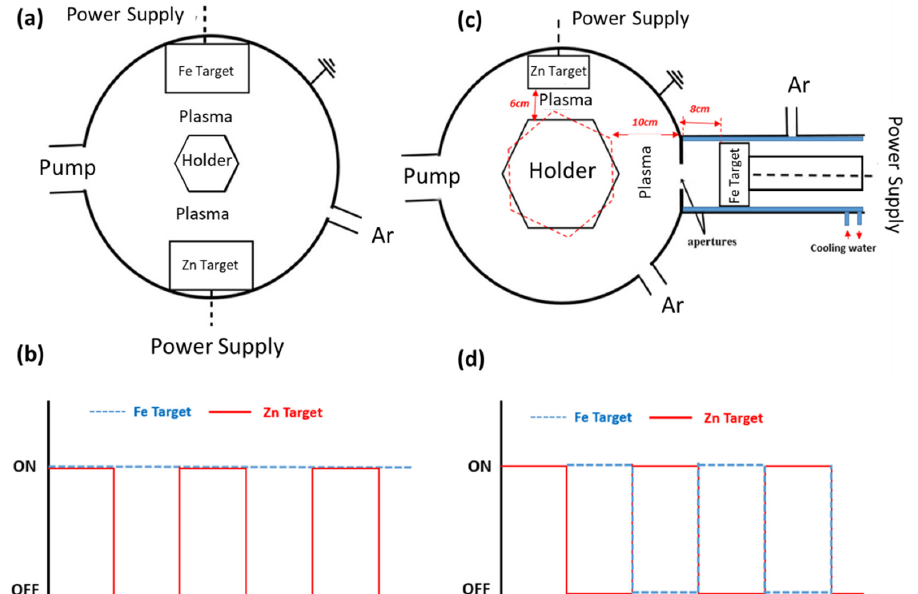
Figure 2. ( a ) Top-view layout for classical magnetron sputtering; ( b ) Zn and Fe target ON/OFF state during classical magnetron deposition; ( c ) top-view layout for hybrid magnetron sputtering with a cluster gun; and ( d ) Zn and Fe target ON/OFF state during hybrid deposition.